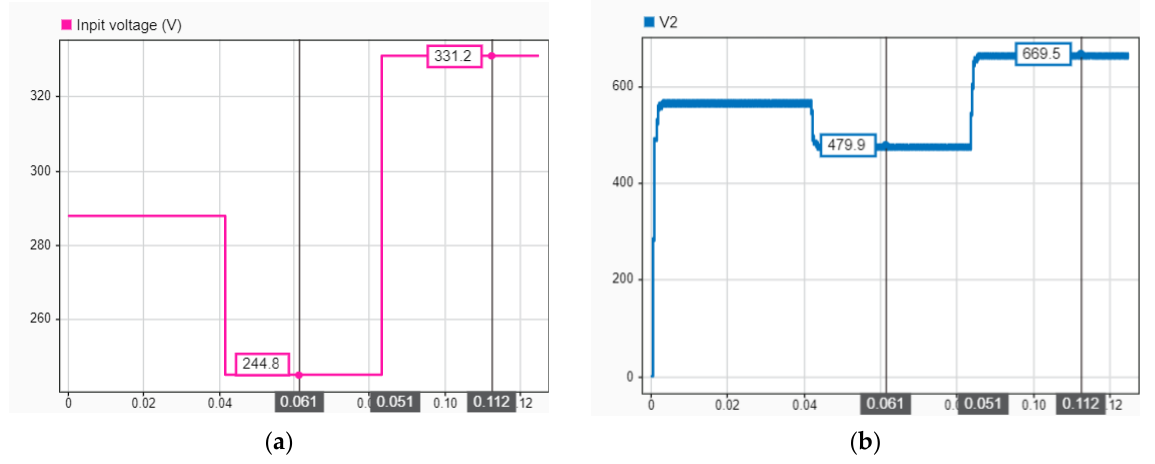
Figure 18. Current and voltage across a power switch of secondary H-bridge for 80 kW DAB DC-